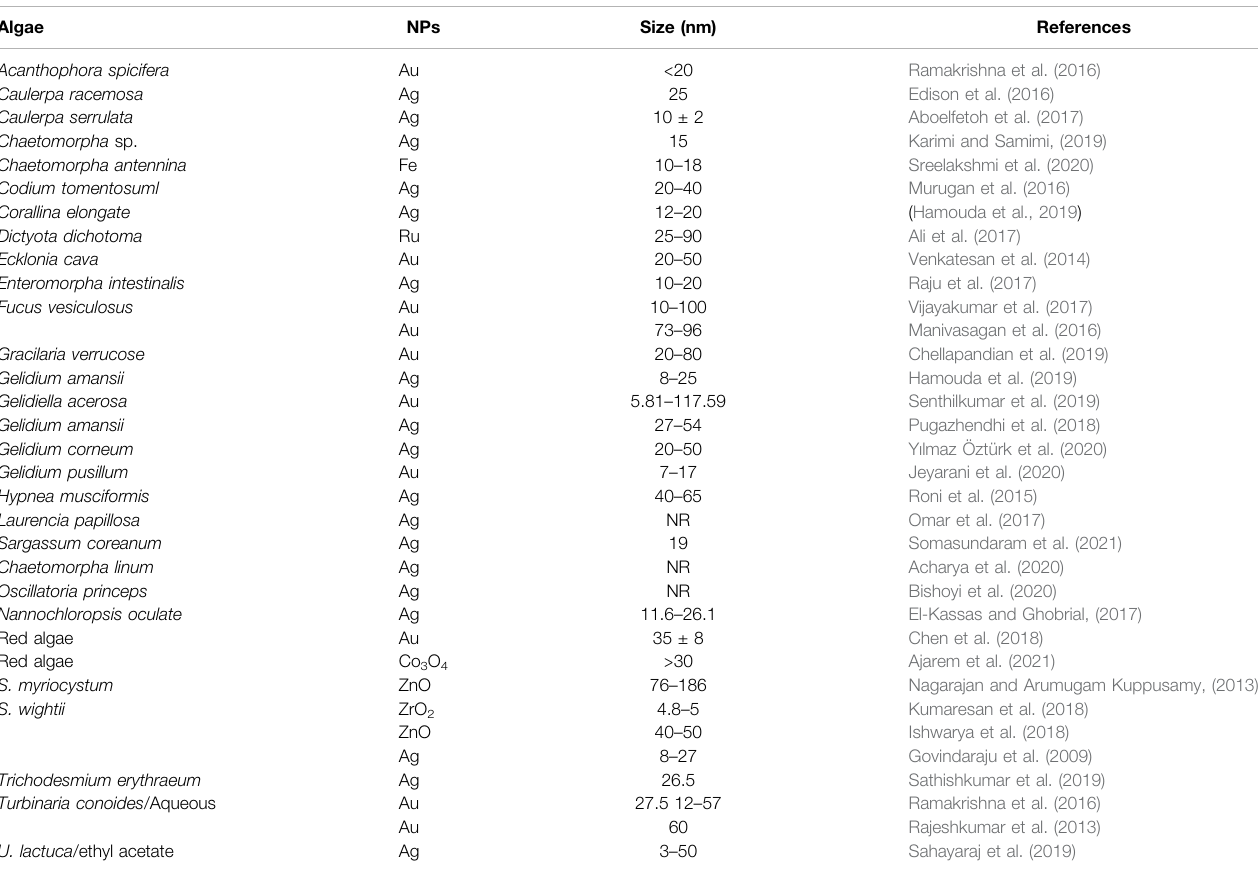
TABLE 4 | Tabular representation of nanoparticles synthesized using algae.